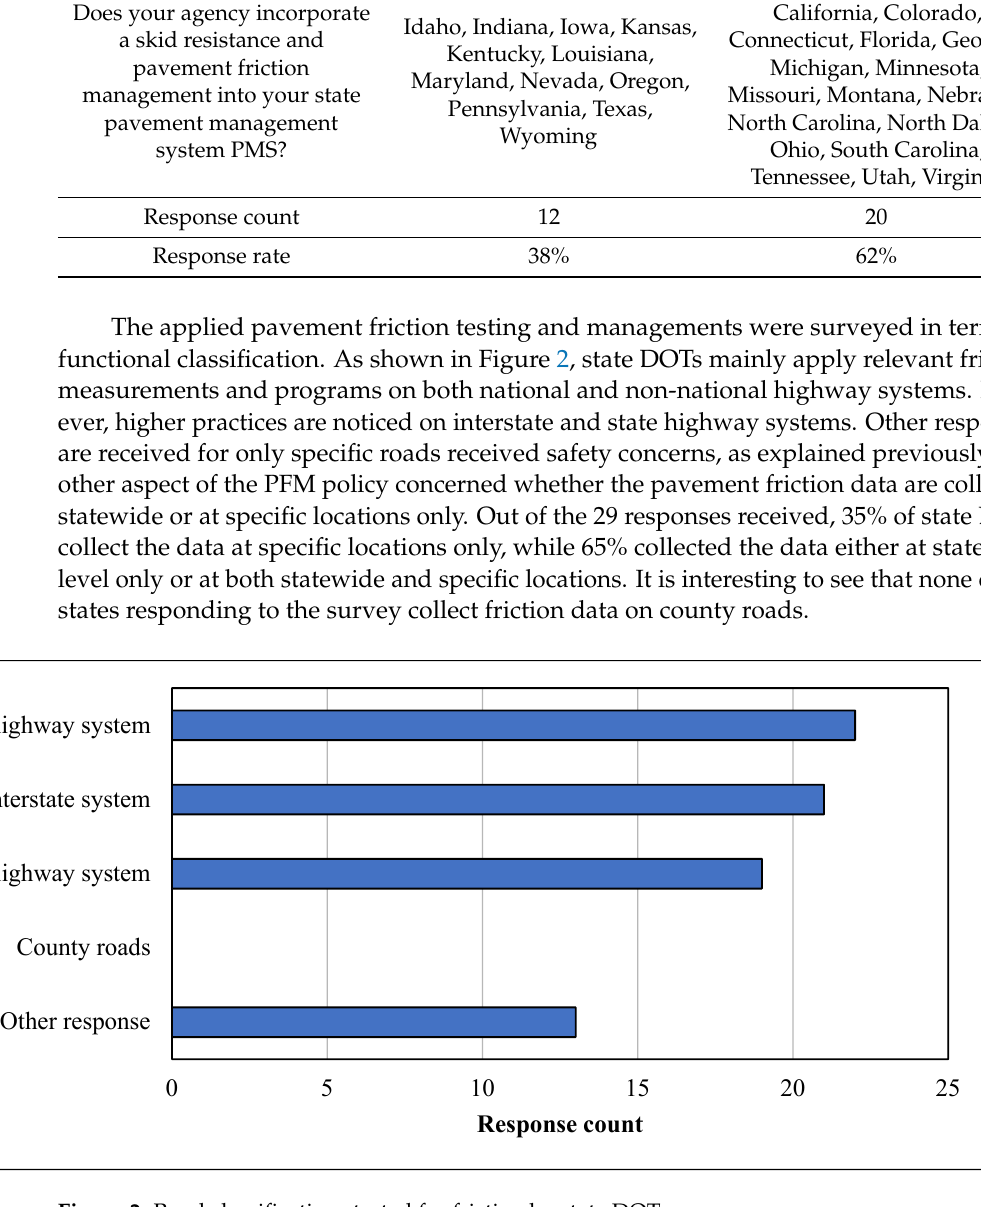
Figure 2. Road classifications tested for friction by state DOTs.